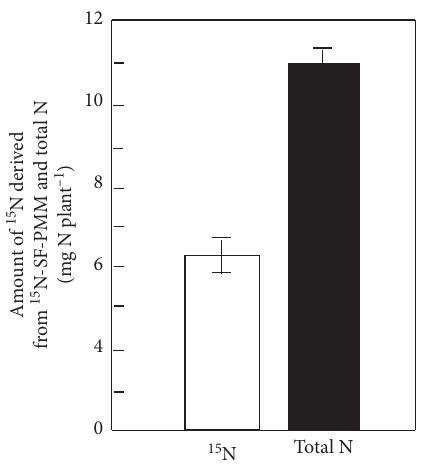
Figure 7: The concentrations of 15 N ( ) and the total amount of N ( ) in the whole plant of komatsuna cultured in the 15 N-SF-PMM- 100 treatment in 5-week experiment. An accumulation of 15 N from the 15 N-SF-PMM into komatsuna was briefly assessed (for the details, see Section 2.4.4). Komatsuna was cultured in the 15 N-SF- PMM-100 treatment in 5-week experiment. In week 5, the two plants were harvested and lyophilized. The lyophilized samples were pulverized, and the aliquots were subjected to 15 N determi- nation with a 15 N analyzer. White column: average of the amount of 15 N incorporated into a plant. Black column: the amount of total N in a plant. Two plants were used to calculate the average. See for details, Section